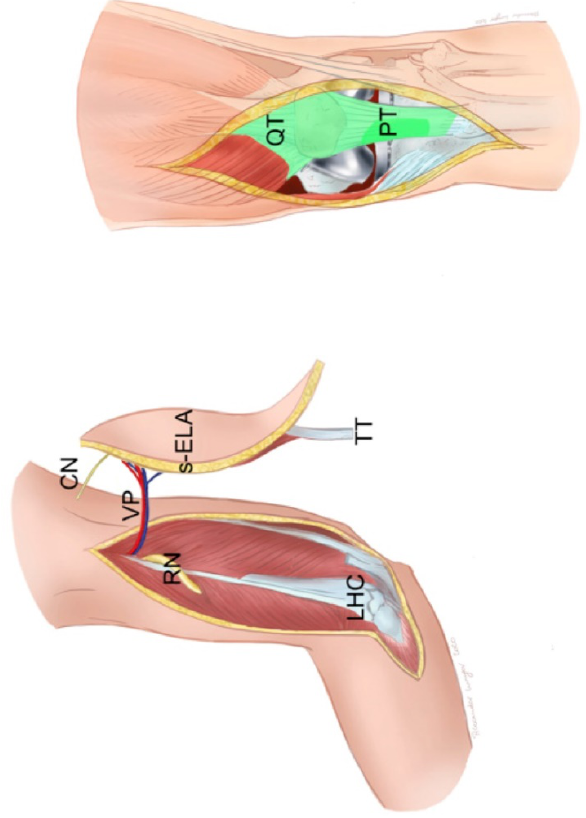
Figure 7: Free sensate extended lateral arm flap (s-ELA): Clinical scenario of PJI after TKA with a soft-tissue defect of up to 7 cm in width and an underlying extensor apparatus deficiency with either a partial patellar tendon (PT) lesion or partial quadriceps tendon (QT) lesion (light green). The s-ELA is raised with a strip of triceps tendon (TT) and part of the lateral head of the triceps muscle. At the proximal end of the flap can be seen the inferior lateral cutaneous nerve (CN) of the arm, which is raised with the flap in order to generate a sensate flap. Of note, the longer the vascular pedicle (VP) is dissected, the closer it lies to the radial nerve (RN), which is prone to neurapraxia. LHC: lateral humeral condyle (Table 1: Patient No. 3; additional Figures 5, 8, 9, 18, 19).